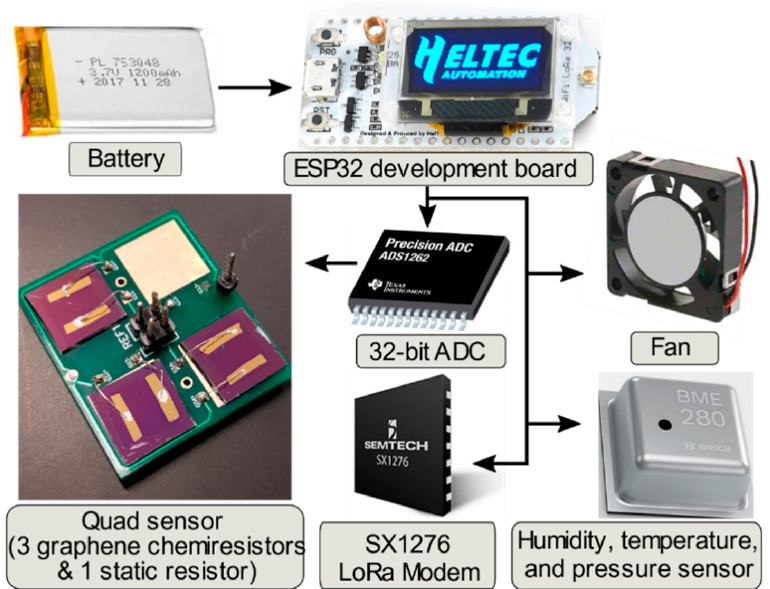
Figure 1. Diagram of the main functional components of the gas sensing platform. A battery powers the development board (ESP32 µ C), which controls the graphene chemiresistor array via a 32-bit analog-to-digital converter (ADC). A fan, a long-range communication (LoRa) module and a commercial humidity/temperature/pressure sensing device are also accessible by the ESP32 µ C using the I2C communication bus.